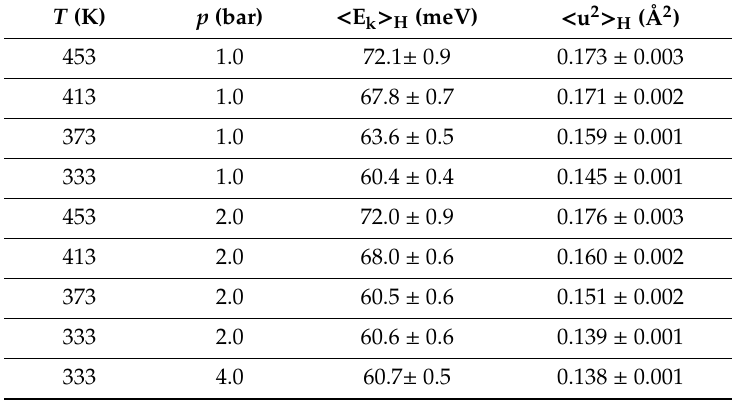
Table 3. Thermodynamic conditions of the samples measured on MARI and experimental results for H mean kinetic energy, < E k > H , and H mean square displacement, < u 2 > H . Statistical errors are also